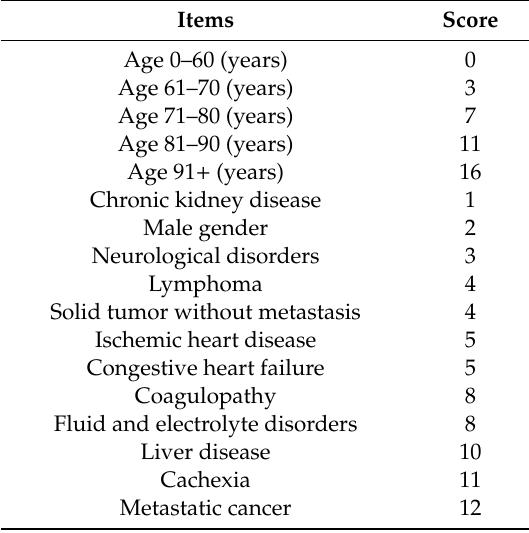
Table 1. Items and relative assigned score to calculate in-hospital mortality (IHM).